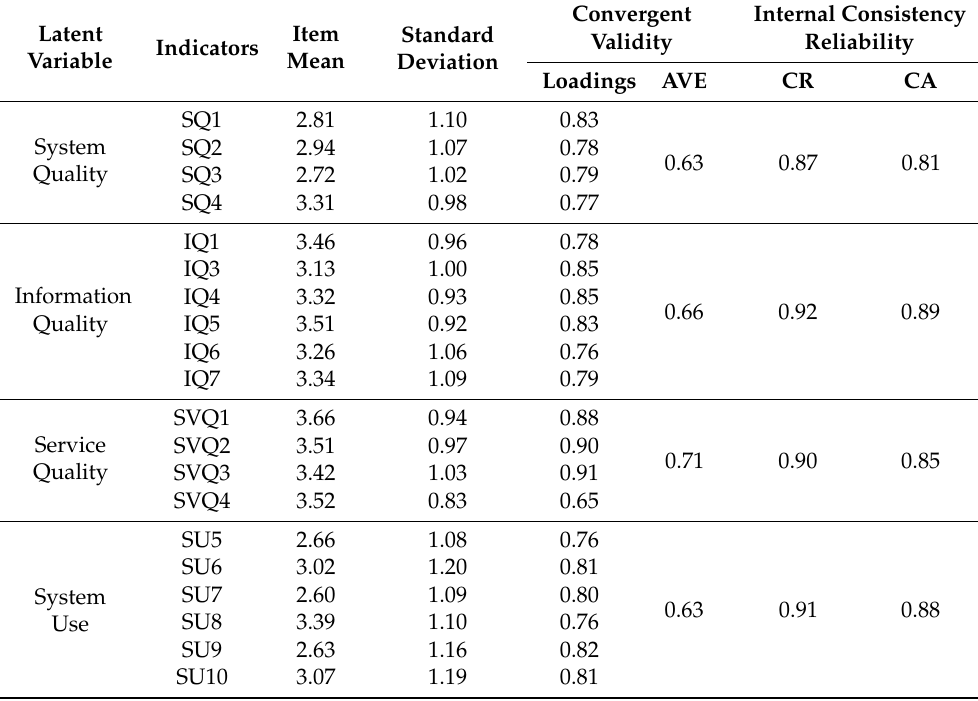
Table 2. Reflective measurement